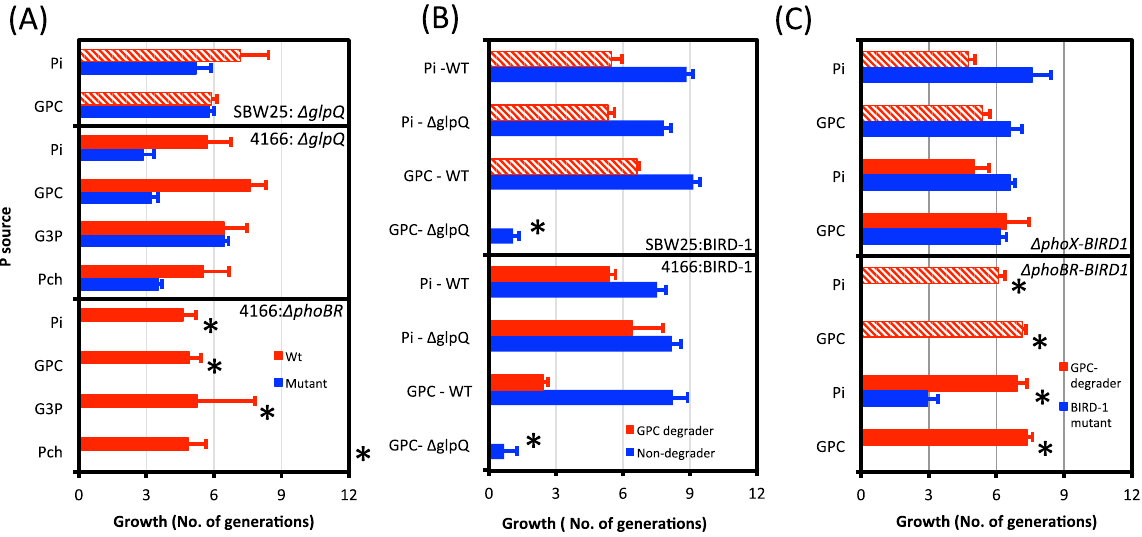
Figure 4. Co-cultivation experiments using various Pseudomonas strains assessing growth on extracellular glycerolphosphorylcholine (GPC) (100 μ M), the potential GPC cleavage product glycerol 3-phosphate (G3P), phosphocholine (Pch), as well as growth on orthophosphate (Pi). Either P . stutzeri DSM4166 (block red) or P . fluorescens SBW25 (hashed red) were used as the GPC utiliser. All blue bars indicate when a strain was the proposed beneficiary of GPC catabolism. Growth was determined by calculating the number of generations based on plate counts for each strain in the co-cultivation experiment. Asterisks represent conditions where the non-GPC degrader did not grow or when growth of a given mutant was significantly reduced compared to the wild type (T-Test P < 0.05). ( A ) Growth of the Δ glpQ mutant in the presence of the parental wild type (WT) strain revealed that the mutants could still grow despite lacking the ability to degrade GPC (Upper and Middle Panel). Note that the P . stutzeri DSM4166 Δ phoBR mutant (lower panel) showed a severe fitness defect (due to loss of expression of the high affinity Pi transporter). ( B ) Both the wild type and Δ glpQ mutants for P . stutzeri DSM4166 and P . fluorescens SBW25 were co-cultivated with P . putida BIRD-1 on either Pi or GPC. ( C ) P . stutzeri DSM4166 and P . fluorescens SBW25 were co-cultivated with various P . putida BIRD-1 mutants ( Δ phoX and Δ phoBR ). Again, the BIRD-1 Δ phoBR mutant does not express the high-affinity Pi transporter. Results shown are the mean of triplicate cultures. Error bars denote standard